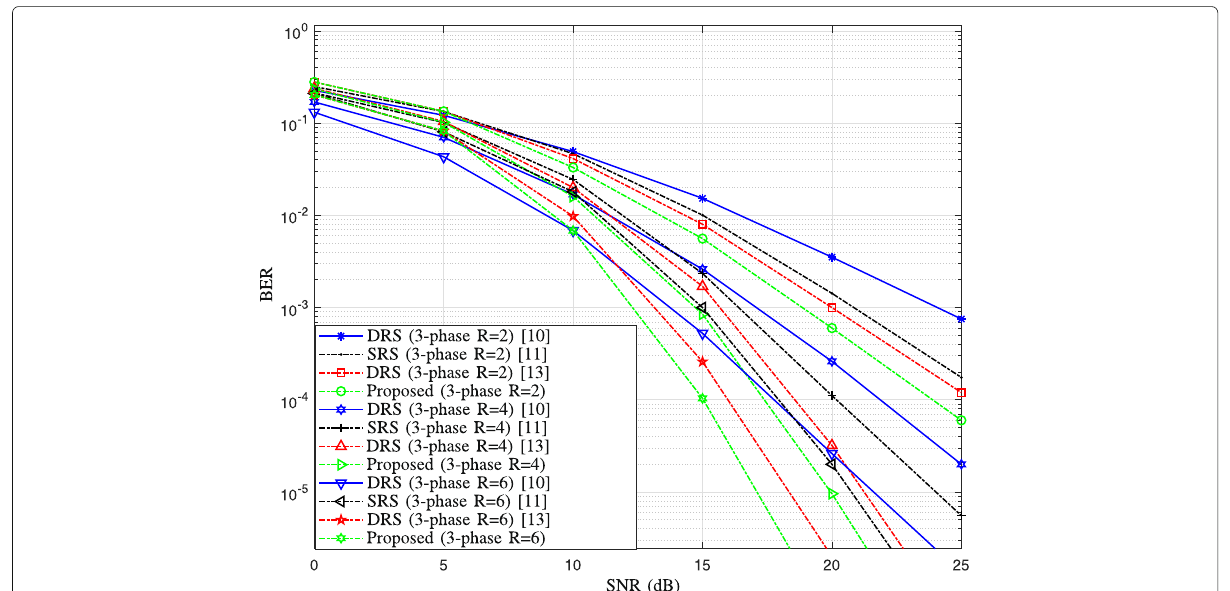
Fig. 4 BER versus SNR for several single and dual relay selection strategies using the three-phase relaying protocol with 8-QAM modulation and R = 2, R = 4, and R = 6